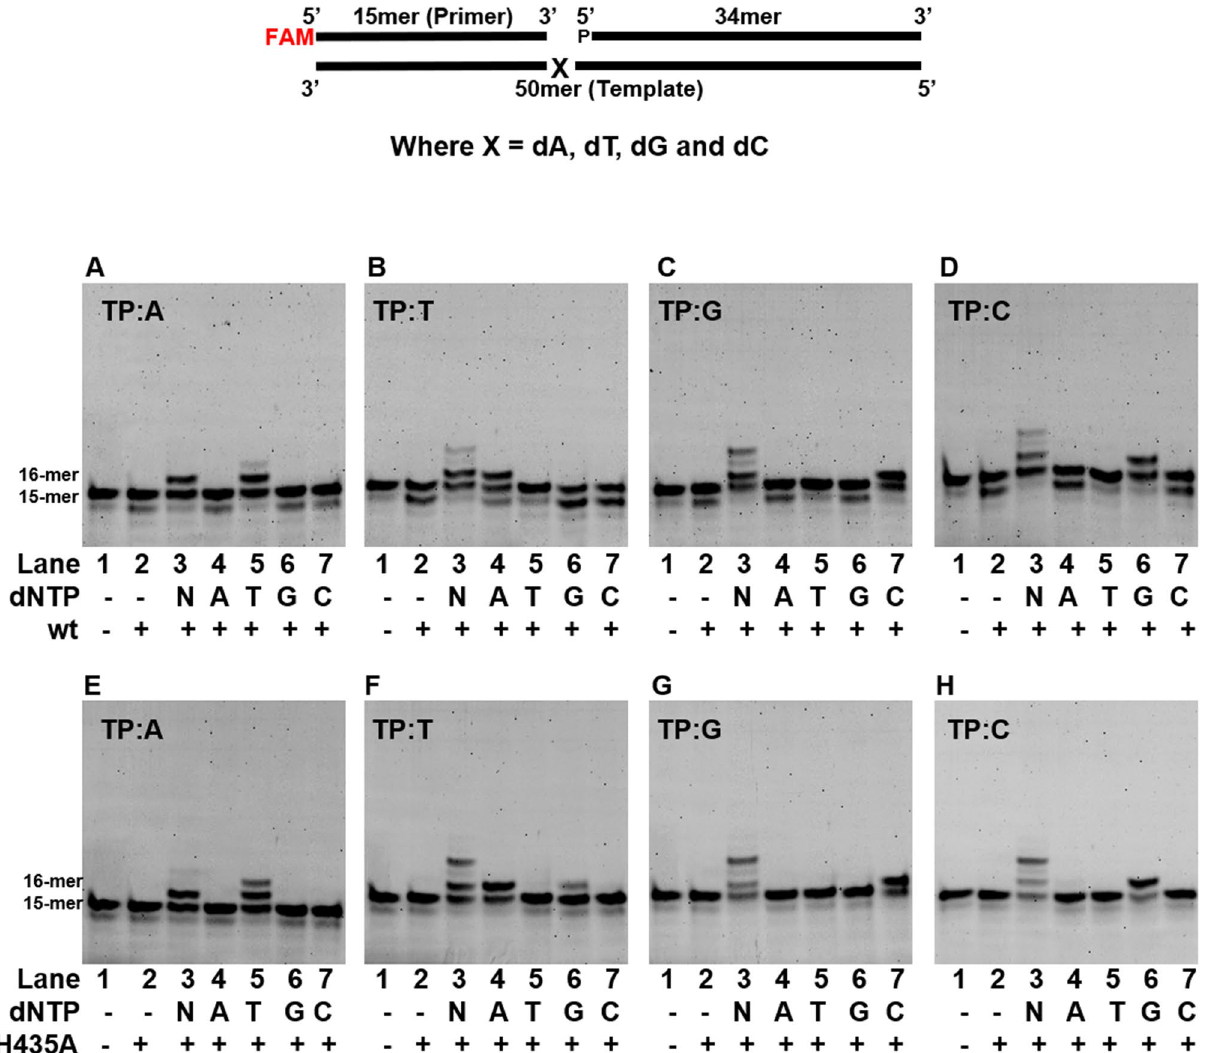
Figure 6. Fidelity of DNA synthesis by saPolX. Primer extension assays were conducted to assess the ability of saPolX to incorporate dATP, dTTP, dGTP and dCTP opposite the four possible template nucleotides- dA, dT, dG and dC. The identity of the template nucleotide is mentioned at the top of each gel. wt-saPolX shows incorporation according to normal Watson–Crick base pairing ( A – D ). H435A mutant shows